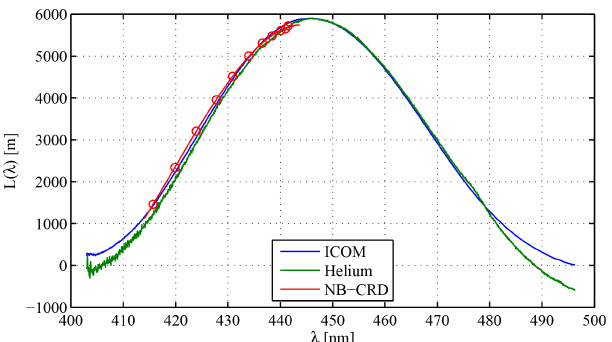
Figure 12. Demonstration of ICOM precision: deviation (cid:49)L i (λ) = L i (λ) − L(λ) of five individually acquired L i values at ν = 10kHz L i (λ)/ 5. The variable from the mean path length L(λ) = (cid:80) 5 i = 1 noise in the spectrum is due to the spectrally non-homogeneous light intensity distribution. The path length assumes its maximum of ∼ 6km at 443nm (Fig. 11; (cid:49)L = 30m corresponds to a relative difference of 0.5%) and is essentially zero at the margins of the spectrometer